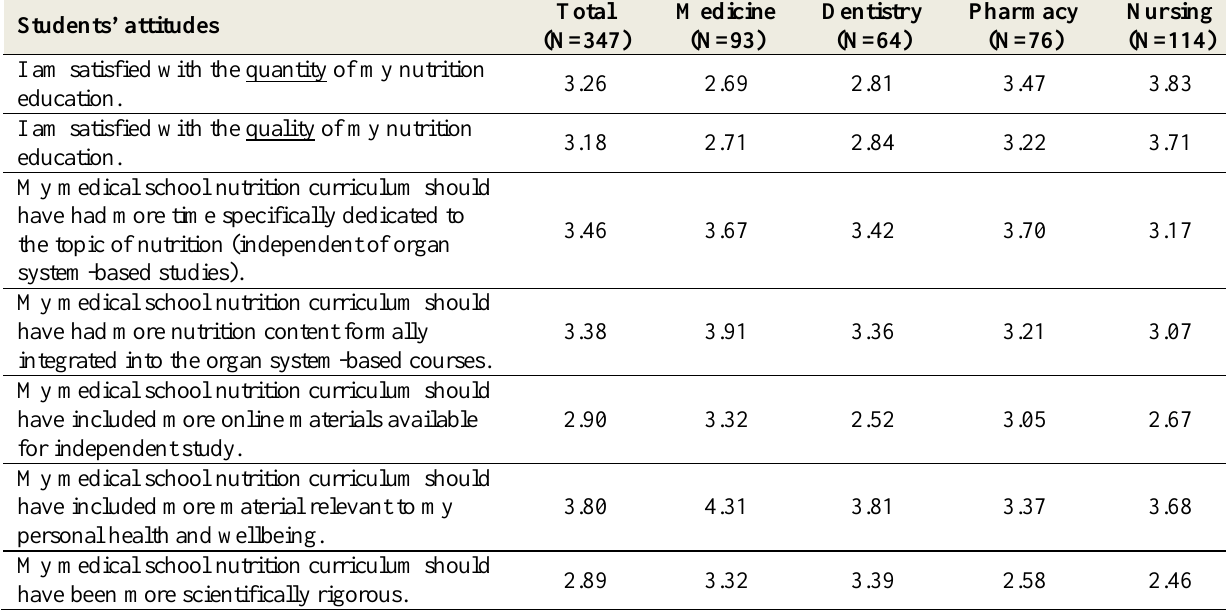
Table 1. Students’ attitudes about their education in the discipline of nutrition Students’ attitudes